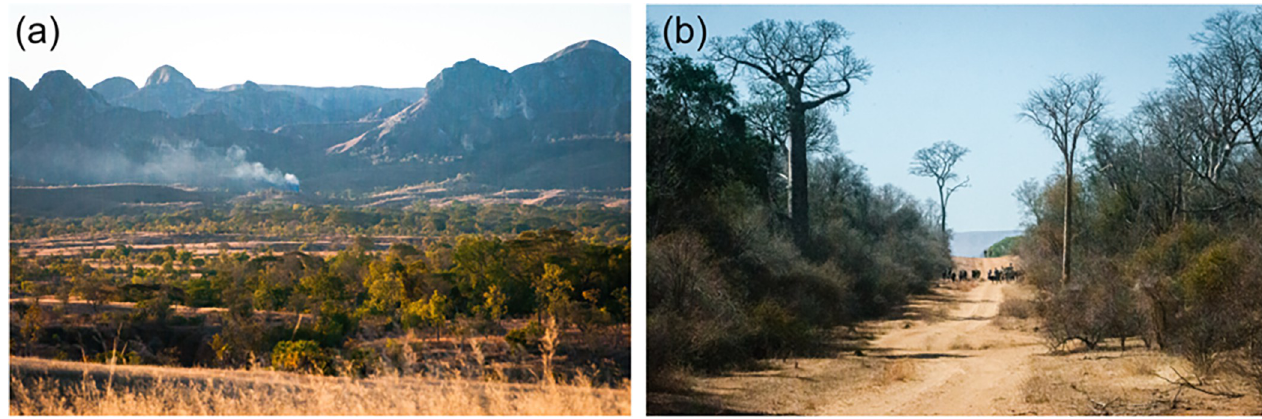
Fig 4. Photographs of the Makay region (author: S. M. Carri è re, date: 2019). (a) The Makay mountainous massif appears in the background, and an anthropogenic fire is visible at its vicinity. (b) A zebu herd crossing a road.